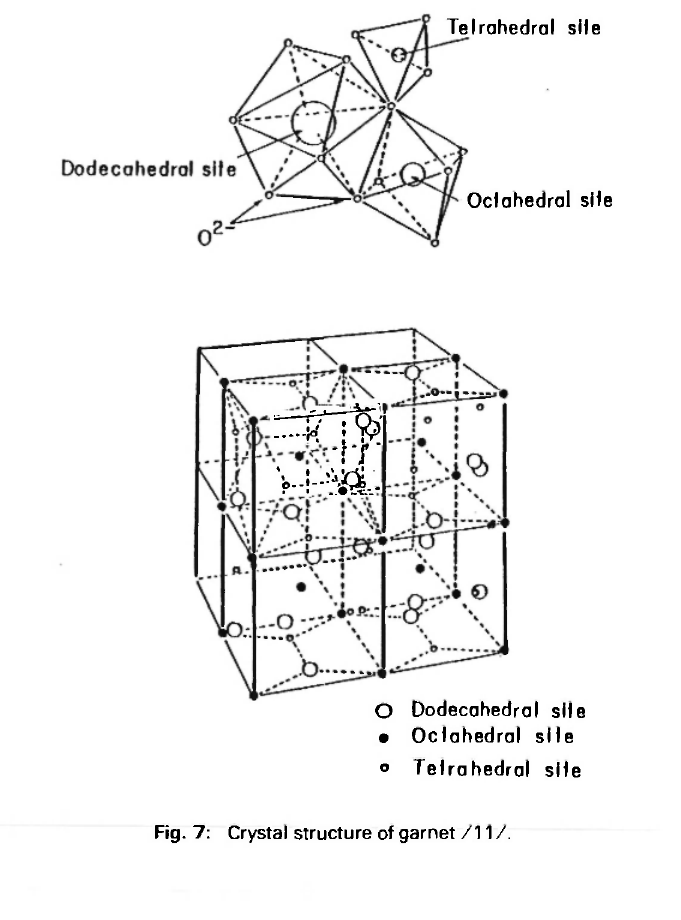
Fig. 7: Crystal structure of garnet